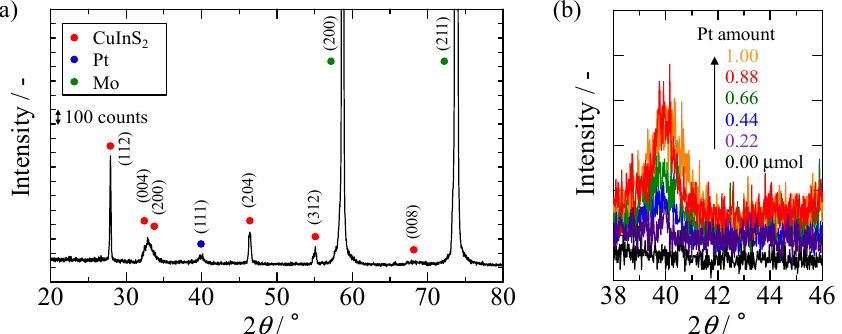
Figure 1. ( a ) XRD pattern of Pt 0.88 / CdS / CuInS 2 electrode. Red, blue, and green dots indicate the positions of the peaks in the standard patterns of CuInS 2 (ICDD #01-082-1702), Pt (ICDD #03-065-7442), and Mo (ICDD #01-087-0646), respectively. ( b ) Magnified patterns around the Pt peak for Pt / CdS / CuInS 2 electrodes.